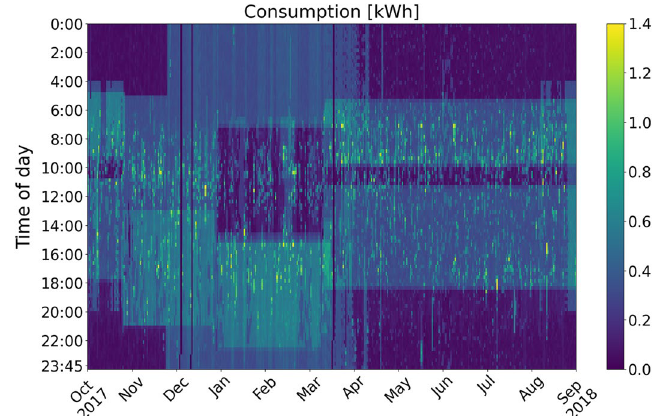
Fig. 5 One year of consumption data of the household with the highest matching accuracy from the 25-household test